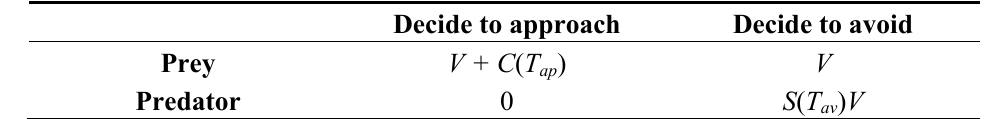
Table 1. Payoff matrix: value of life following a decision depends on the situation, chosen behaviour, and time to decide on that